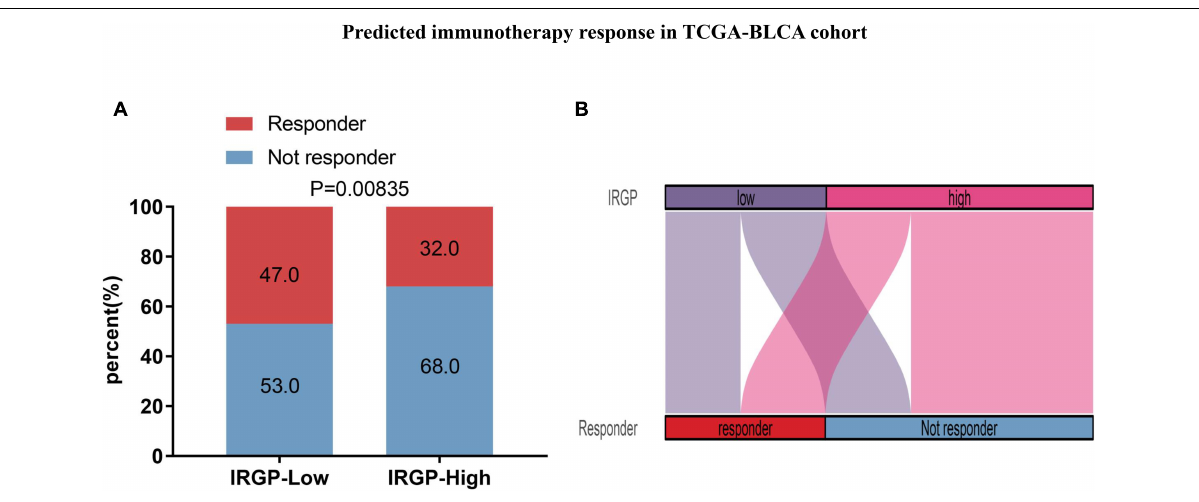
FIGURE 8 | Predicted immunotherapy response in TCGA-BLCA cohort. (A) Comparation of immunotherapy responder between two risk groups. (B) Sankey chart displays the distribution of responder and